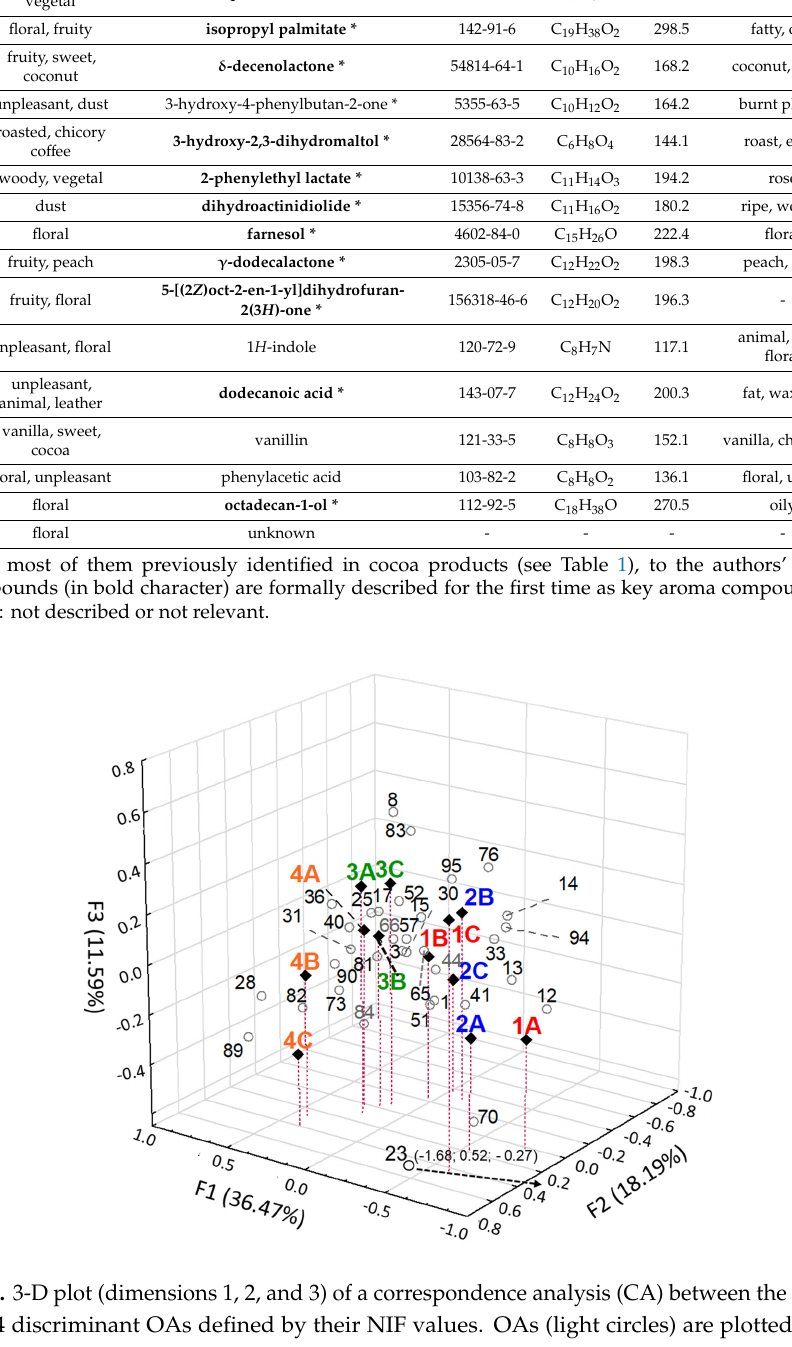
Figure B2. Hierarchical cluster analysis (HCA) conducted on the samples with the NIF values of the 34 OAs determined as discriminant based on 50% NIF difference threshold, displaying four clusters. The data were centered and scaled; dissimilarity Euclidian distances were used with the Ward amalgamation method.